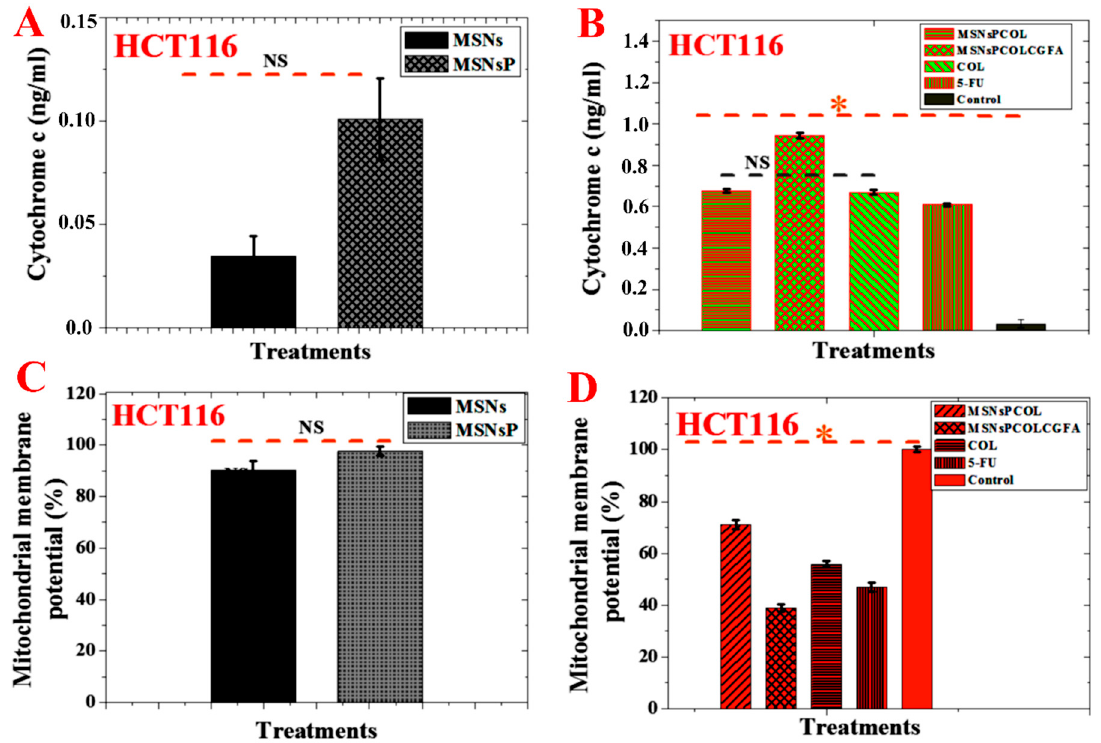
Figure 10. ( A ) Cytochrome c triggering of HCT116 cells treated with MSNs and MSNsP at 500 µg/mL. ( B ) Cytochrome c triggering of HCT116 cells treated at 60 µg/mL with the proposed delivery system for 72 h and compared to the model anticancer drug (5-FU) and control (without any treatment). ( C ) Mitochondrial membrane potential ( Δψ m) of HCT116 cells treated with MSNs and MSNsP at 500 µg/mL. ( D ) Mitochondrial membrane potential of HCT116 cells treated at 60 µg/mL with the proposed delivery system for 72 h and compared to the model anticancer drug (5-FU) and control. Note: An orange asterisk (*) indicates significant ( p < 0.05) differences between tested samples. NS, not significant. All data are expressed as mean ± SD.